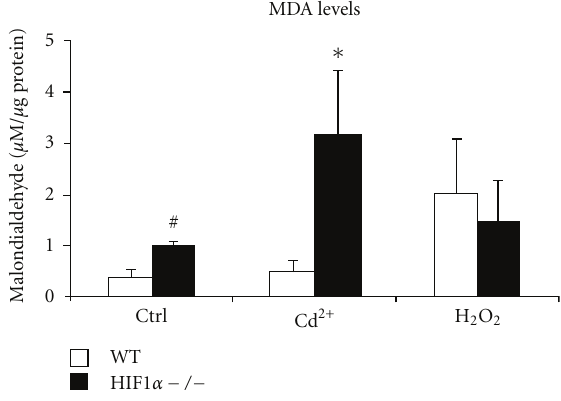
Figure 7: Lipid peroxidation under CdCl 2 treatment. Lipid perox- idation levels were determined in wild type (WT, white bars) and HIF1 α − / − (black bars) by measuring malondialdehyde (MDA) levels. Cells were left untreated (Ctrl), or treated with 5 μ M CdCl 2 (Cd 2+ ) for 24 hours or 2mM H 2 O 2 for 4 hours. ∗ P < 0 . 05 compared to respective controls, n = 4. # P < 0 . 05, significant compared to wild-type cells, n =